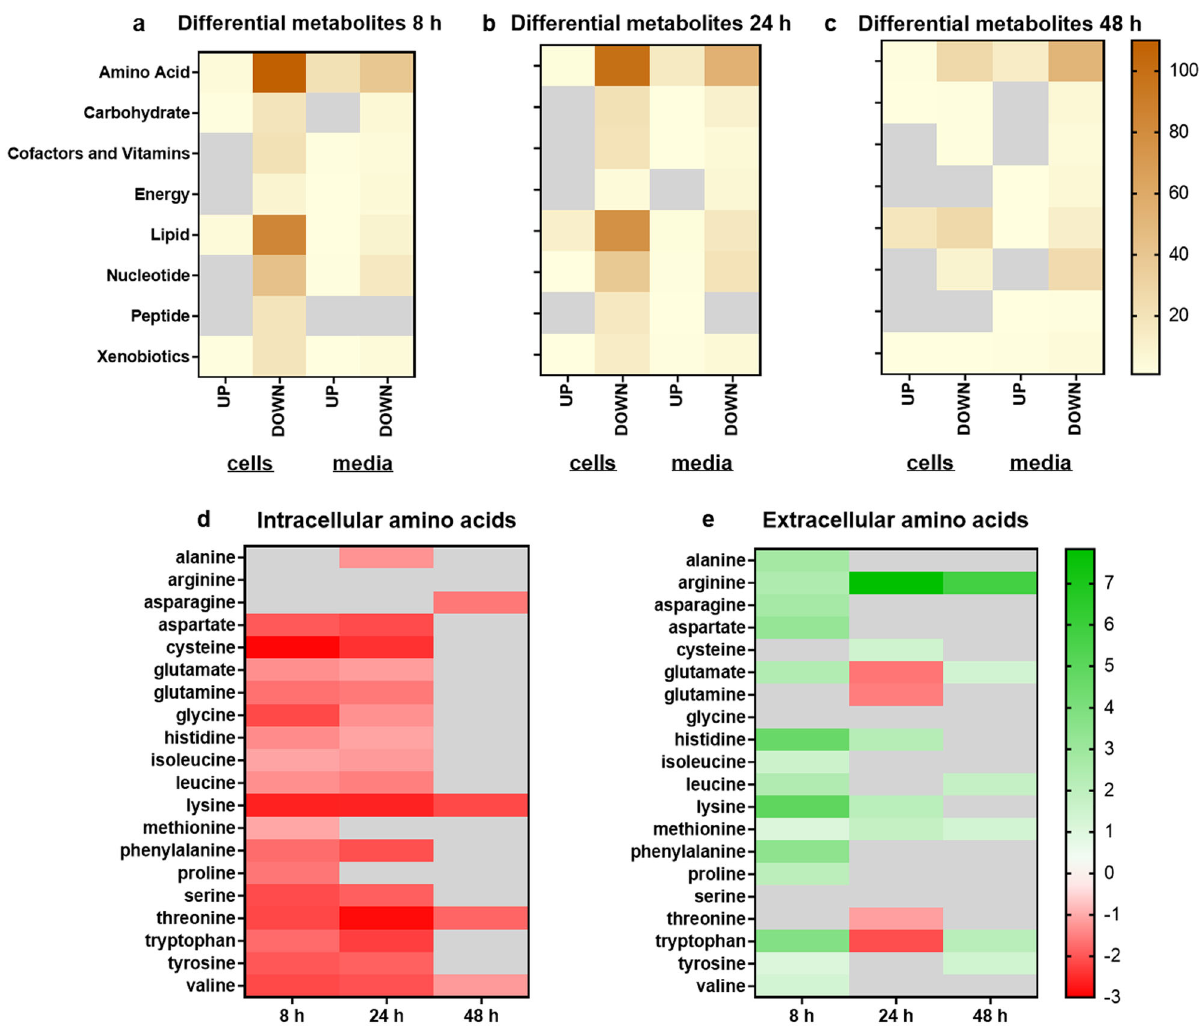
Fig. 6 Intracellular and extracellular metabolomics in hypoxic vs. normoxic bio fi lms. Metabolomes from cells and media from hypoxic bio fi lms were compared to normoxic bio fi lms and numbers of signi fi cant changes (cutoff p < 0.05 and log 2 FC ± 1) were plotted for main metabolic pathways. Numbers of differentially abundant metabolites were analyzed and summarized according to the respective pathways for ( a ) 8 h, ( b ) 24 h, and ( c ) 48 h bio fi lms. Signi fi cant changes (log 2 FC) in the abundance of intracellular ( d ) and extracellular amino acids ( e ) were plotted. Source data are provided as a Source Data fi